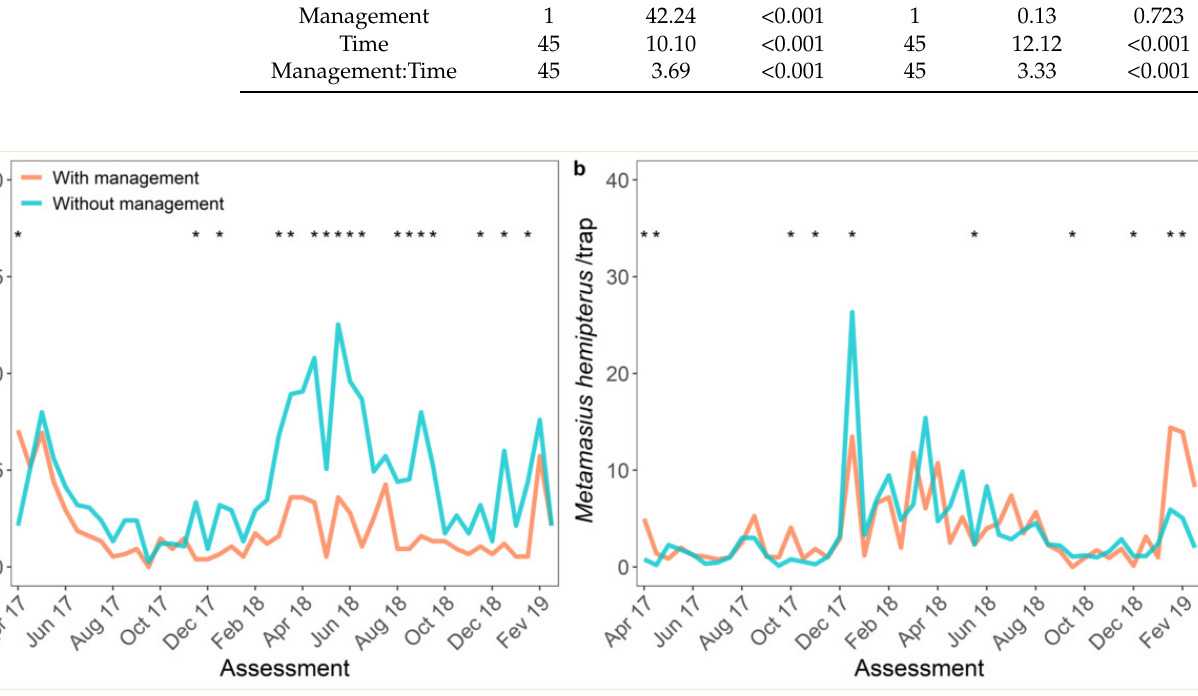
Figure 1. Biweekly monitoring of: ( a ) weevil borer ( Cosmopolites sordidus , WB) and ( b ) false weevil borer ( Metamasius hemipterus , FWB) in plots with and without control of WB, from April 2017 to February 2019. Significant differences ( p < 0.05) by pairwise t -test comparison of the effects of management at a given assessment time are represented by an asterisk.